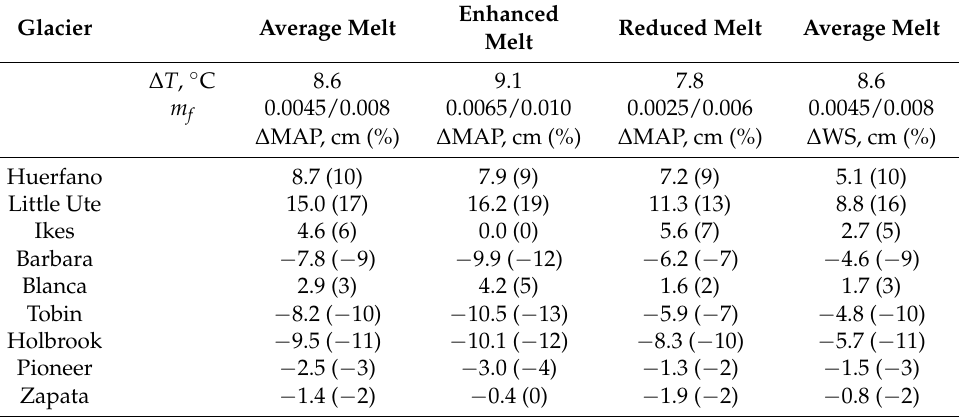
Table 3. Changes in mean annual ( ∆ MAP) or winter/spring precipitation ( ∆ WS) required for steady- state mass balance under the assumptions of uniform LGM temperature depression, ∆ T . Percentages are rounded to nearest whole